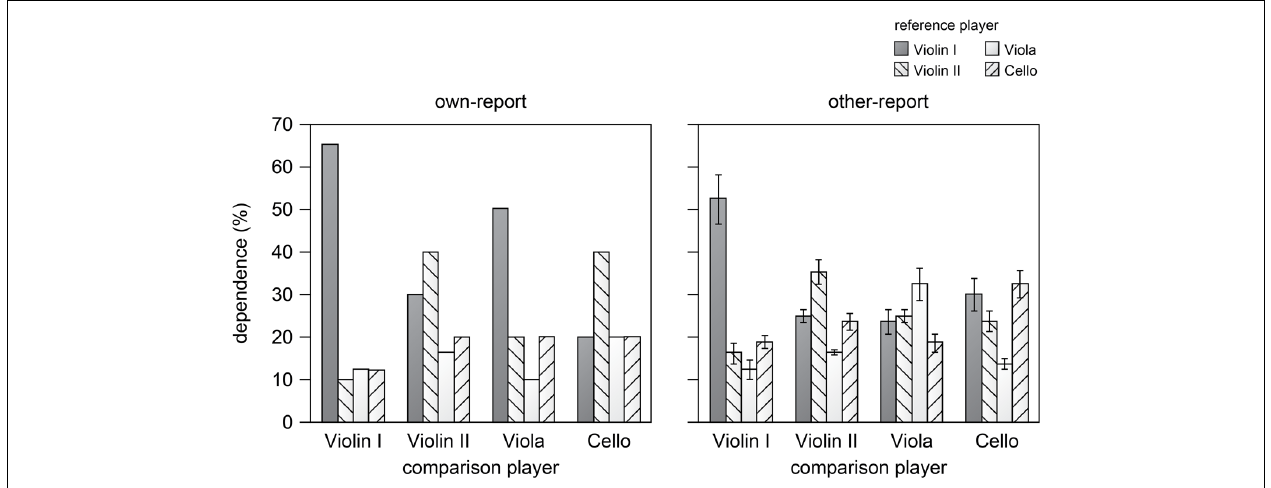
FIGURE 4 | Subjective ratings of the timing dependency of a performer (main player) on the timing of other performers (reference player) judged by the performer him or herself (left panel) and judged by the other performers (right panel). The error bar represents one standard